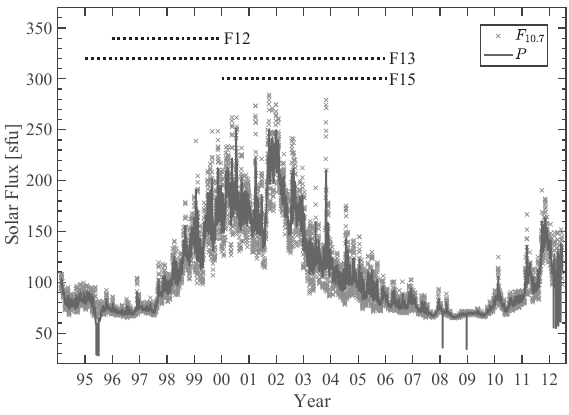
Figure 2. Daily F 10.7 and P index between 1995 and 2012. The dashed lines at the top show the time range of DMSP-F12, F13 and F15, respectively.